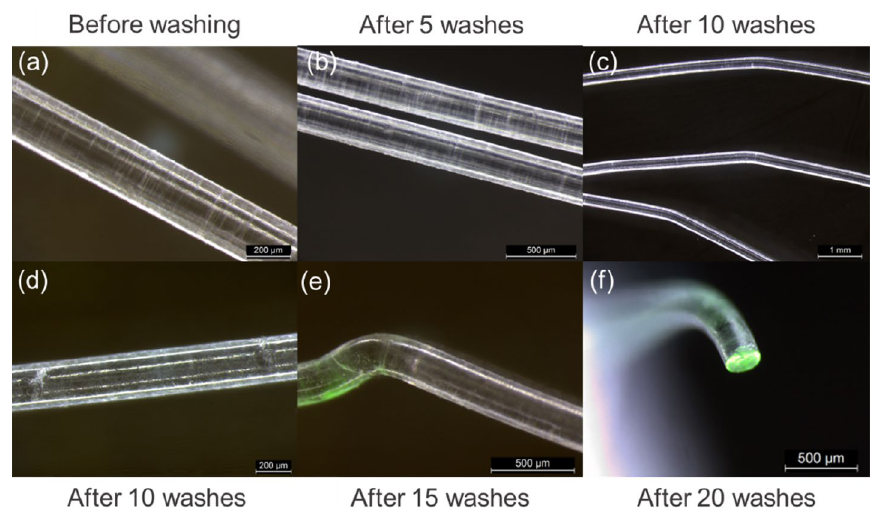
Fig. 6 Optical microscopic images of POF before and after washing: a original; b after 5 washes; c and d after 10 washes; e after 15 washes; and f after 20 washes